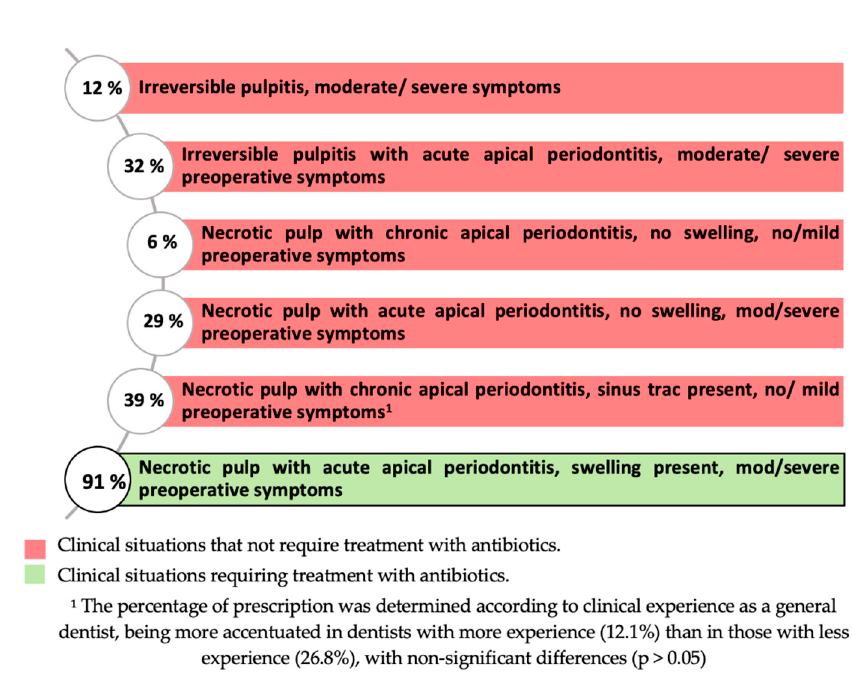
Figure 4. Antibiotic prescription according to the type of endodontic infection.